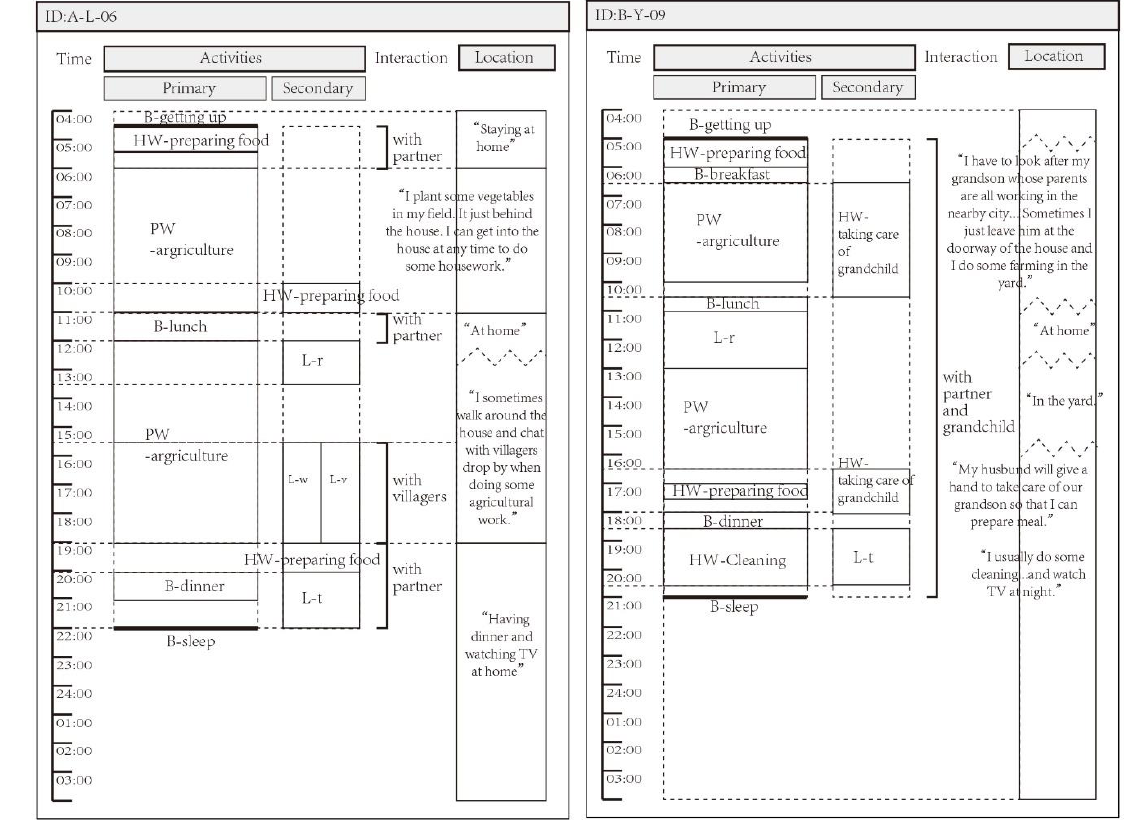
Figure 1. Prepared forms and on-site recordings of the activities and locations.